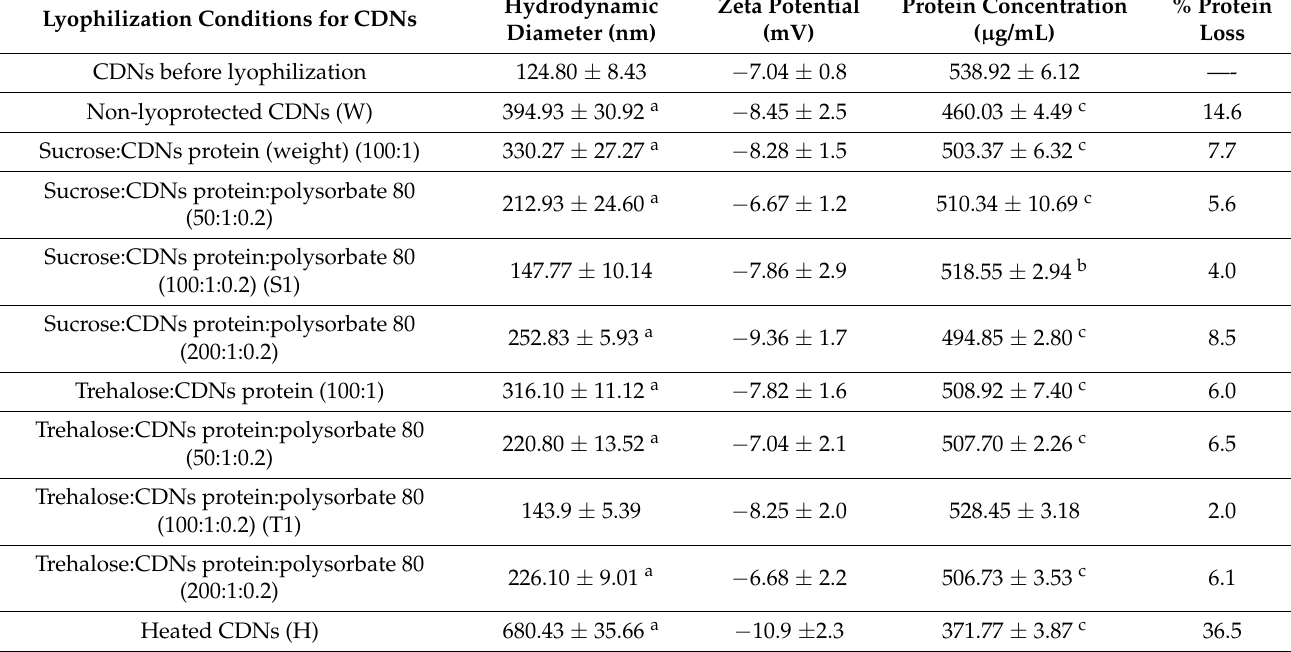
Table 1. Effect of lyoprotectant type and amount on physicochemical properties of CDNs after lyophilization. Hydrodynamic diameter, zeta potential, and protein concentration of lyophilized CDNs were determined after reconstitution. Results shown are mean ± SD of three independent experiments. a p < 0.001, b p < 0.01, c p < 0.001 compared with fresh CDNs before